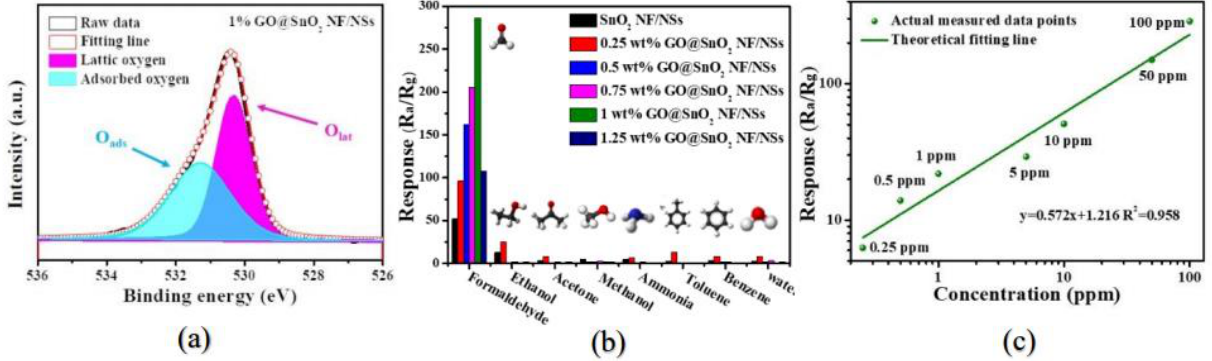
Figure 13. ( a ) O1s of pure SnO 2 NF/NSs and 1% GO@SnO 2 NF/NSs nanocomposites, respectively; ( b ) responses of the gas sensors to different test gases at their respective optimal operating temperatures; ( c ) linear approximation of the detection limit with 1% GO@SnO 2 NF/NSs nanocomposites [82].